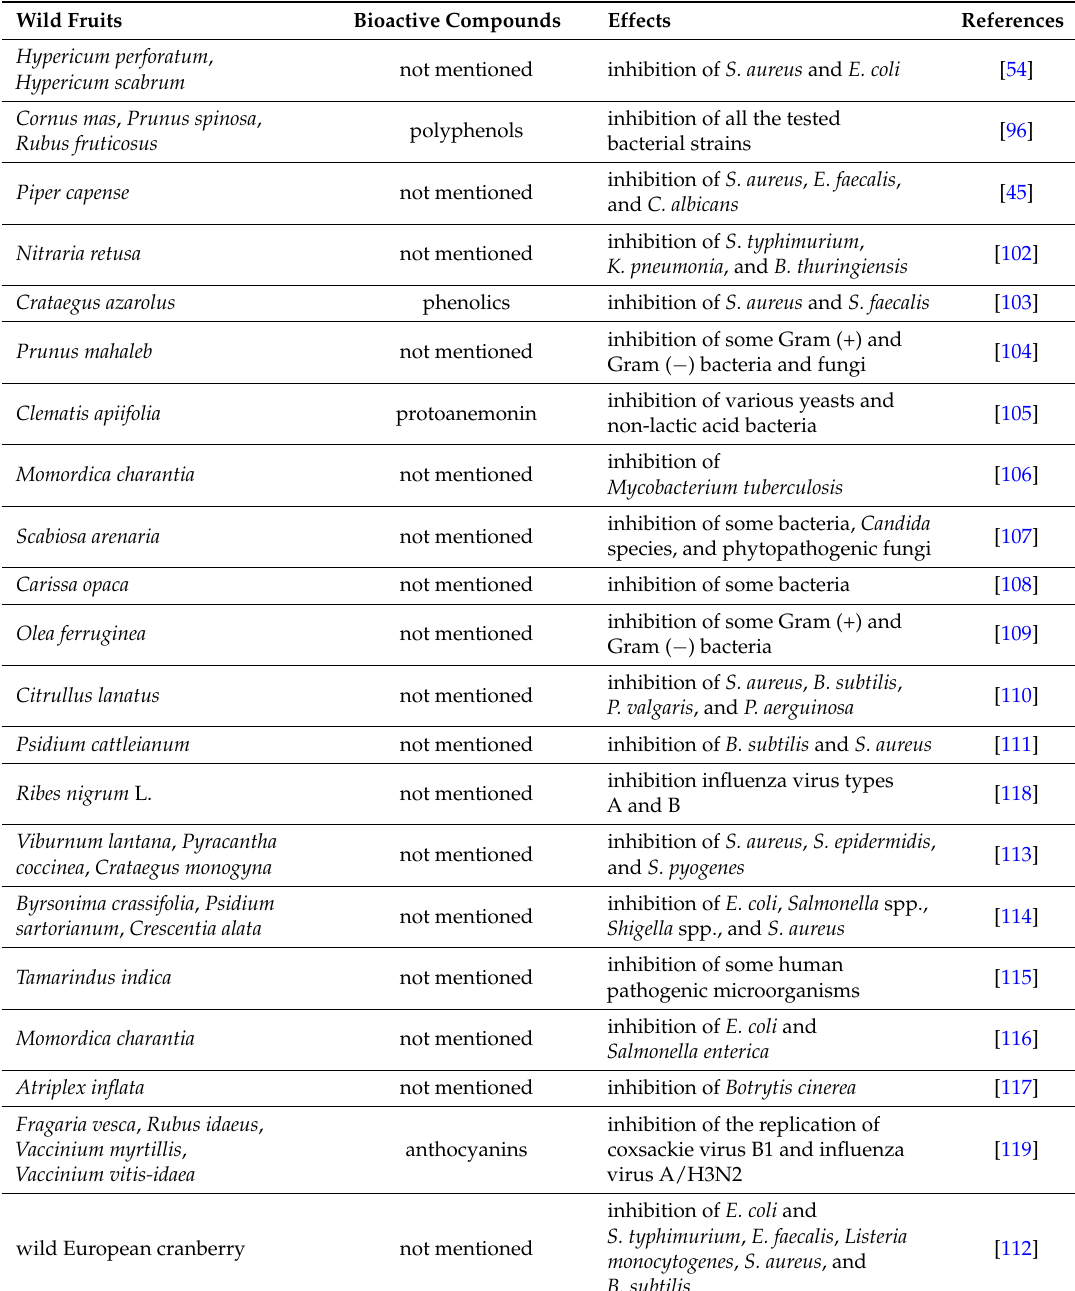
Table 2. Antimicrobial activities of some wild